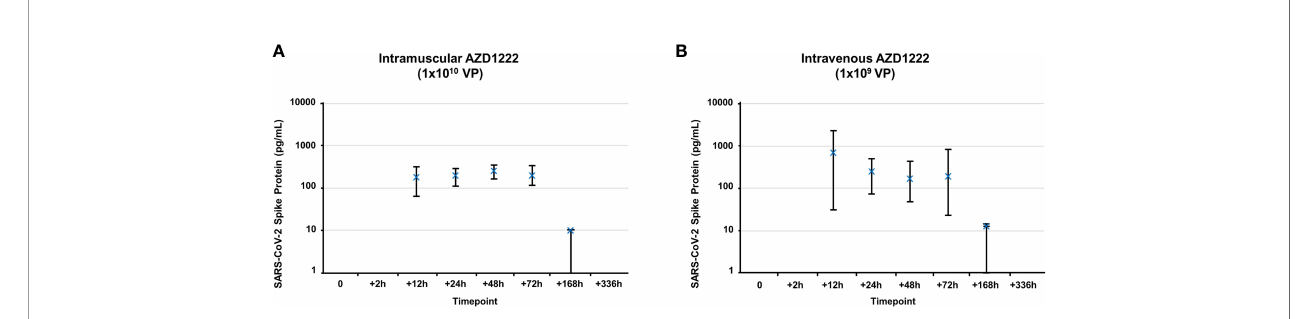
FIGURE 2 | Kinetics of S1 subunit detection following AZD1222 immunization. Levels of SARS-CoV-2 spike protein S1 subunit detected in serum following IM (A) or IV (B) AZD1222 immunization. Data points represent mean SARS-CoV-2 Spike protein concentrations observed in male and female mice. Error bars indicate minimum and maximum concentrations per